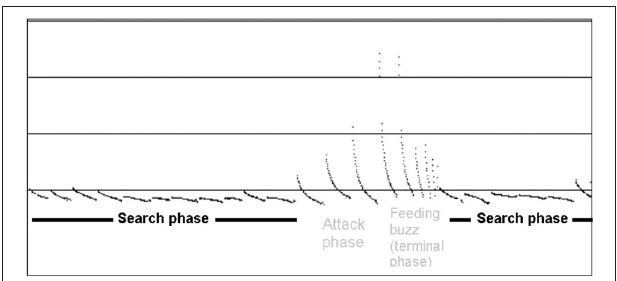
FIGURE 3 | Example diagram shows search phase and feeding buzz call features of a Mormopterus species, used for identification during data analysis (figure reproduced from Pennay et al., 2004).